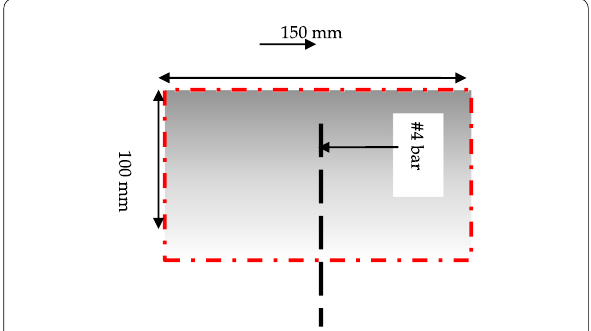
Fig. 4 Pull‑out test sample